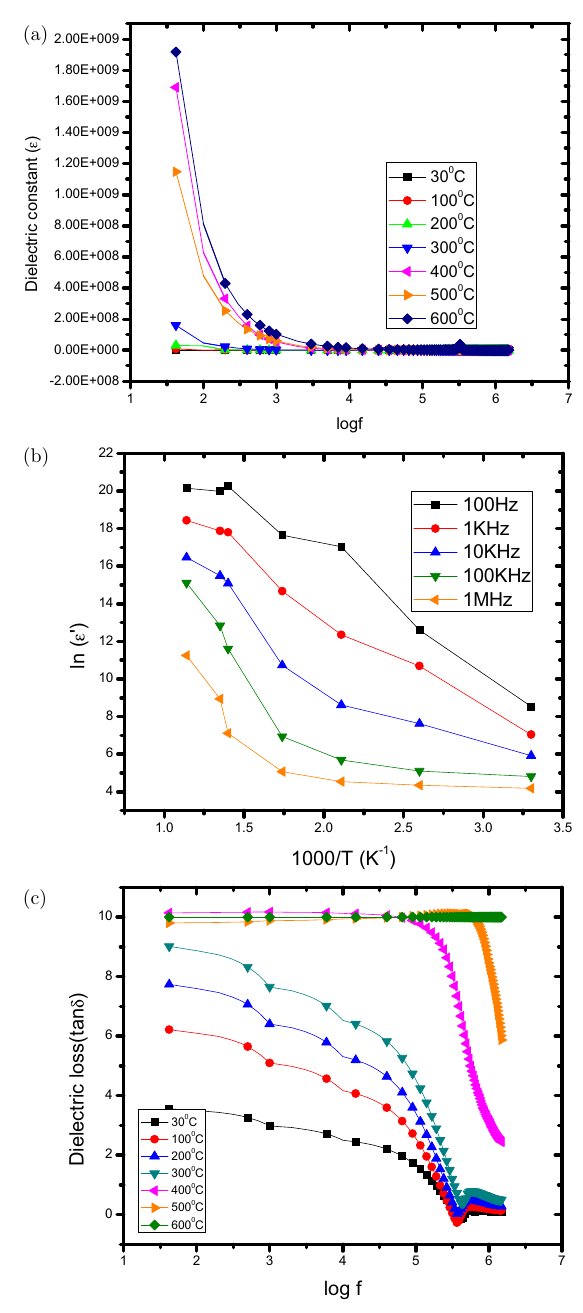
Fig. 3. (a) Frequency dependence of dielectric constant of Pb 2 Sr 2 CaCu 2 O 9 at di®erent temperatures, (b) Temperature dependence of dielectric constant of Pb 2 Sr 2 CaCu 2 O 9 at di®erent frequencies and (c) Frequency dependence of dielectric loss of Pb 2 Sr 2 CaCu 2 O 9 at di®erent